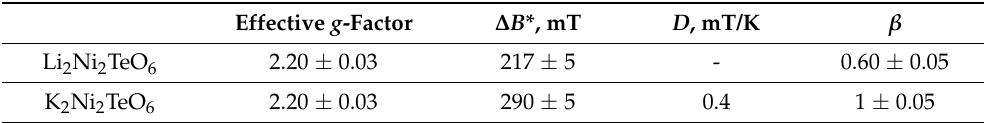
Table 4. The spin-dynamic parameters in A 2 Ni 2 TeO 6 (A = K and Li) tellurates. Effective g